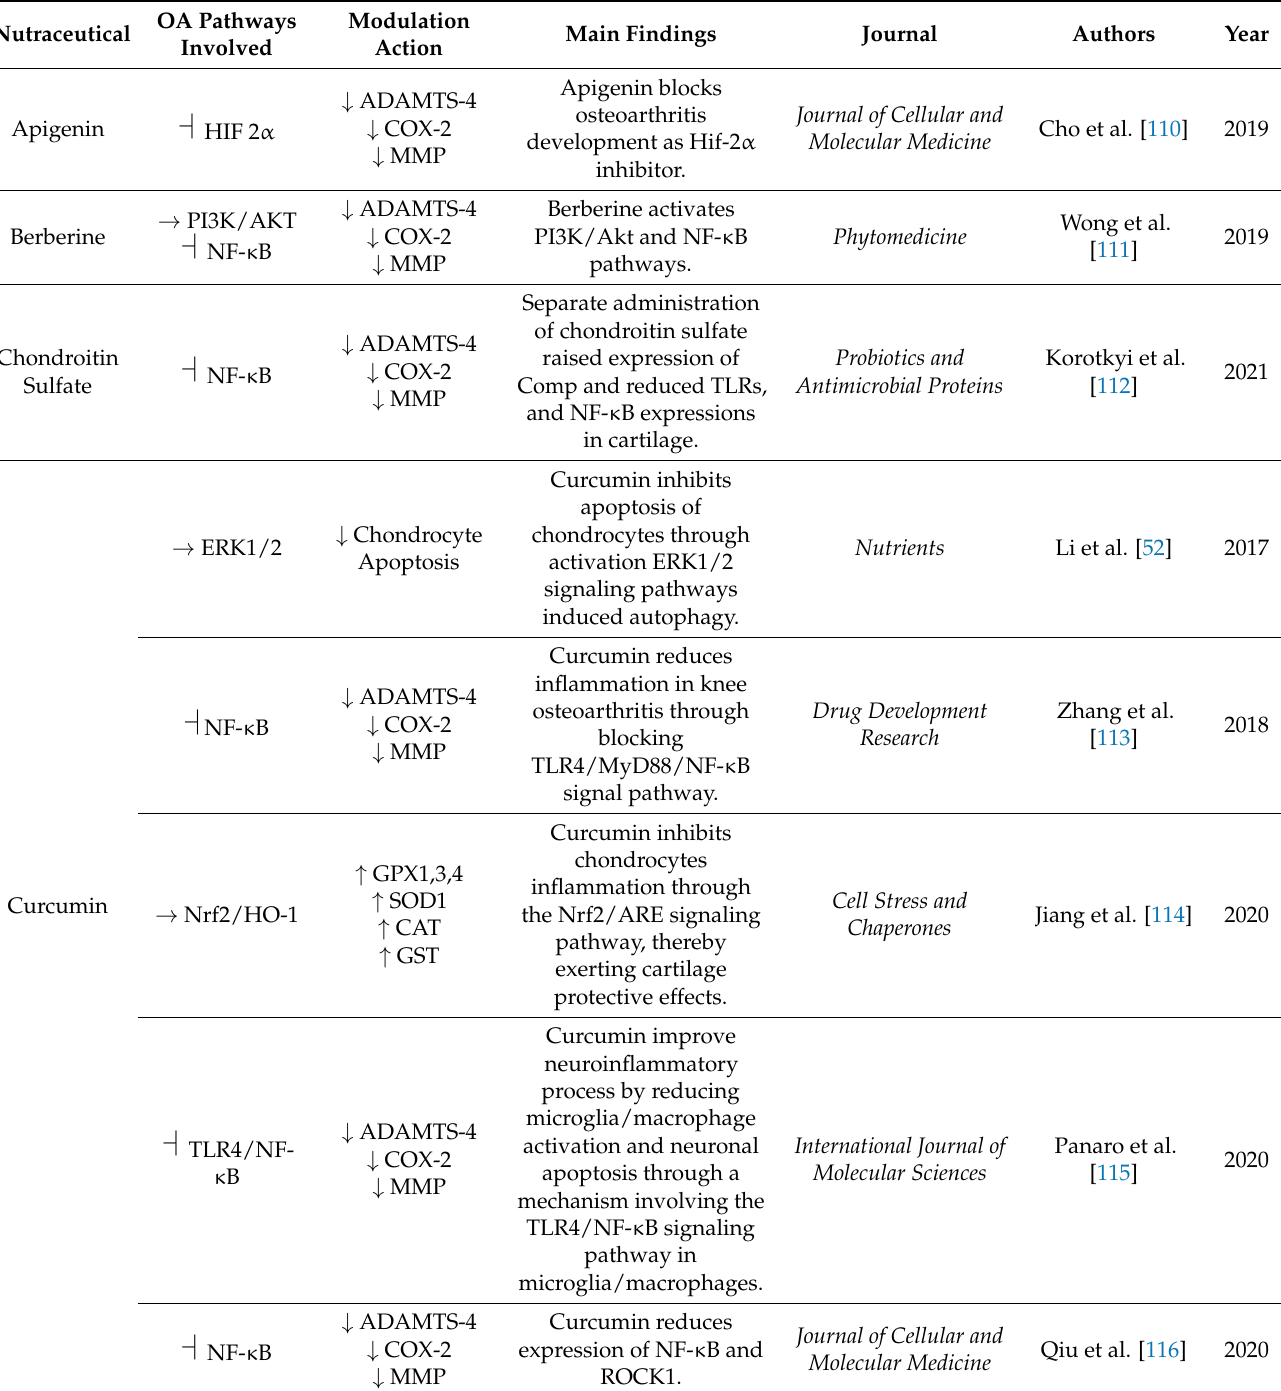
Table 1. Characteristics of the studies included with the nutrigenomic